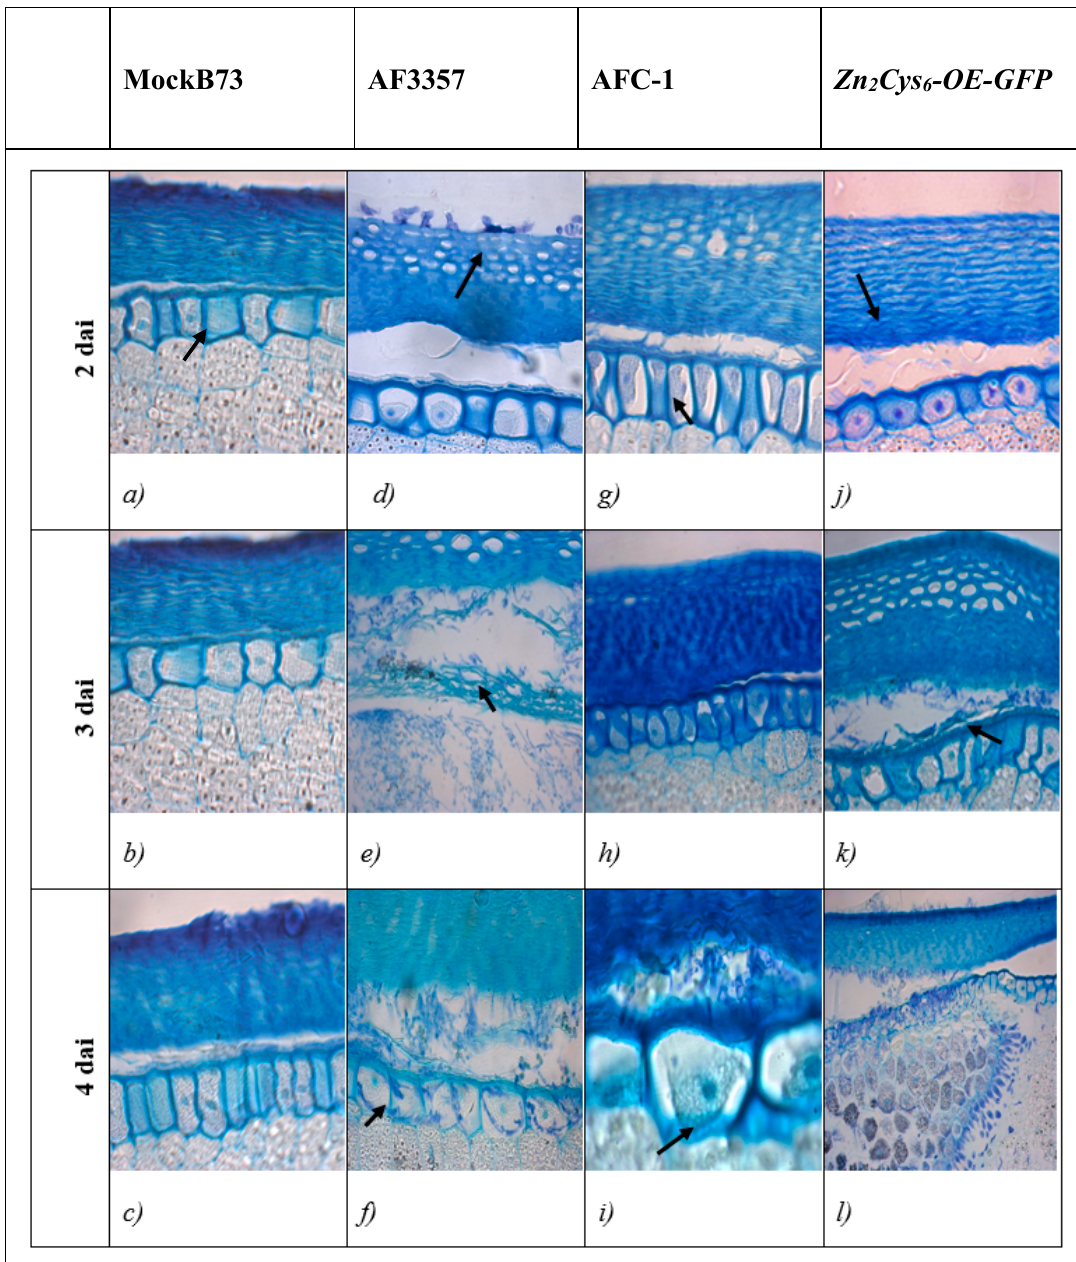
Figure 1. Histological assays showing the progression of the infection by different strains at 2, 3 and 4 dai. MockB73 ( a – c ) tissues were not infected at any time point. Wild-type AF3357 ( d – f ) spores are present just outside the kernel at 2 dai ( d ), and at 4 dai the fungus had directly invaded the aleuronic cells as shown by the arrow ( f ). Starting at 2 dai, the AFC-1 mutant ( g – i ) experienced visible vacuolisation of aleuronic cells (arrows in g ) as symptoms of PCD onset, progressing to 4 dai with ongoing infection ( i ). The transcription factor overexpressing mutant, Zn 2 Cys 6 -OE-GFP ( j – l ), as a consequence of fungal invasion caused detachment of the periderm from the aleuronic layer (arrow in j ), then proceeds just outside the aleuronic layer (arrow in k ) until the kernel is collapsed ( l ). Magnification 400×.